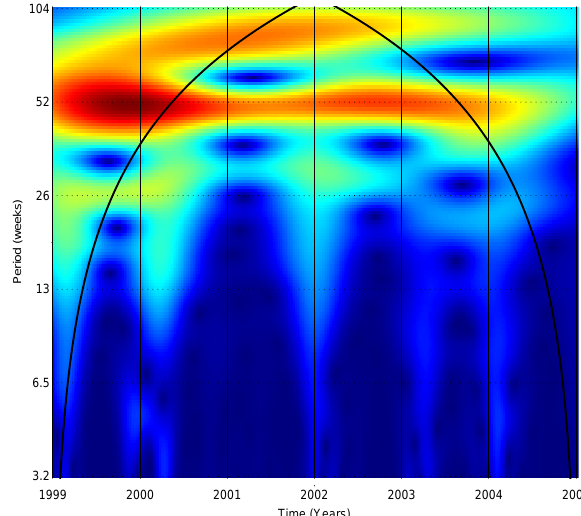
Figure 6: The power spectrum of the CWT of the cholera case data allows variations to be observed according to scale (period). A nonorthogonal transform is used to produce smooth continuous variations in power. A cone of influence is applied to the power spectrum due to the errors that occur at the beginning and end of the transform. Note in particular the power visible in the 52-week period, visible as the darker horizontal band within the lighter